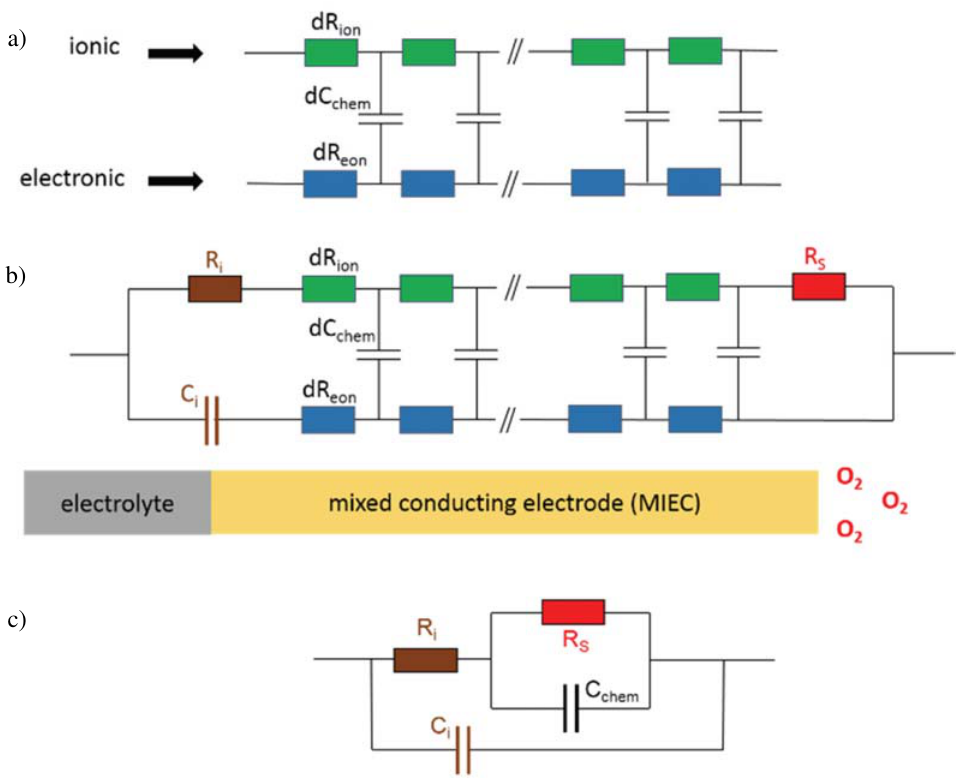
Fig. 2. (a) Transmission line-type equivalent circuit of a mixed conductor with differential chemical capacitances dC electronic rails of charge transport. The parallel geometrical sample capacitance (C elements for a homogeneous mixed conducting electrode in a solid oxide fuel/electrolysis cell with oxygen exchange at the surface (resistor R interfacial charge transfer resistance